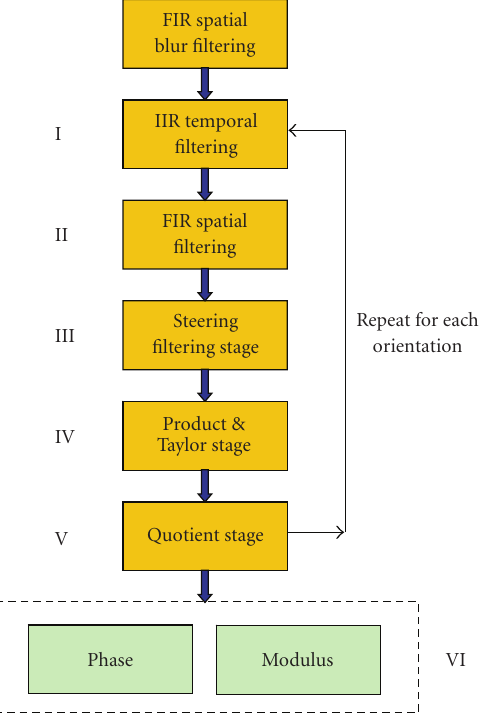
Figure 1: General scheme of the McGM